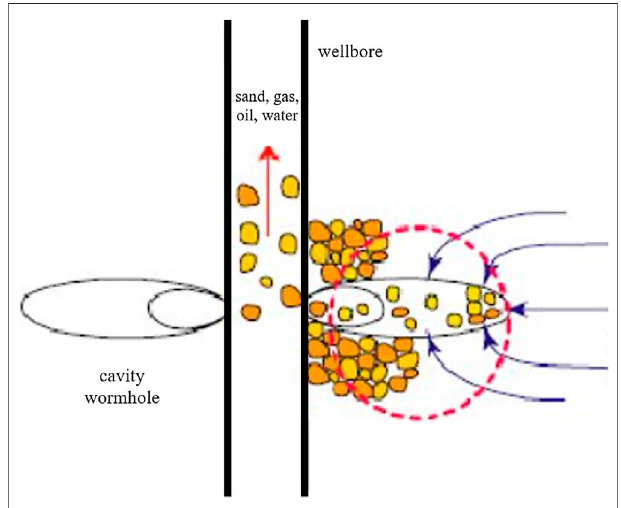
FIGURE 1 | Sand production